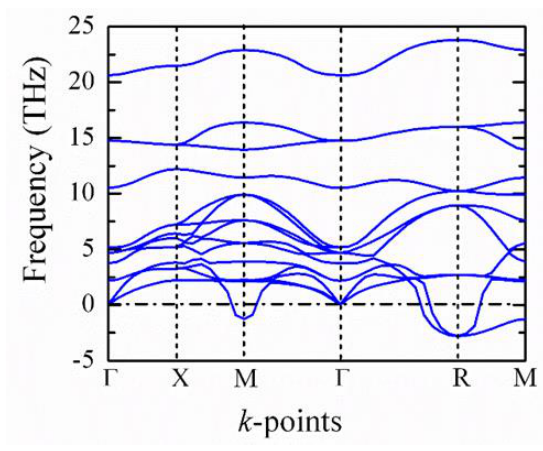
Figure 8. Phonon dispersion relation of BZO crystals [13].